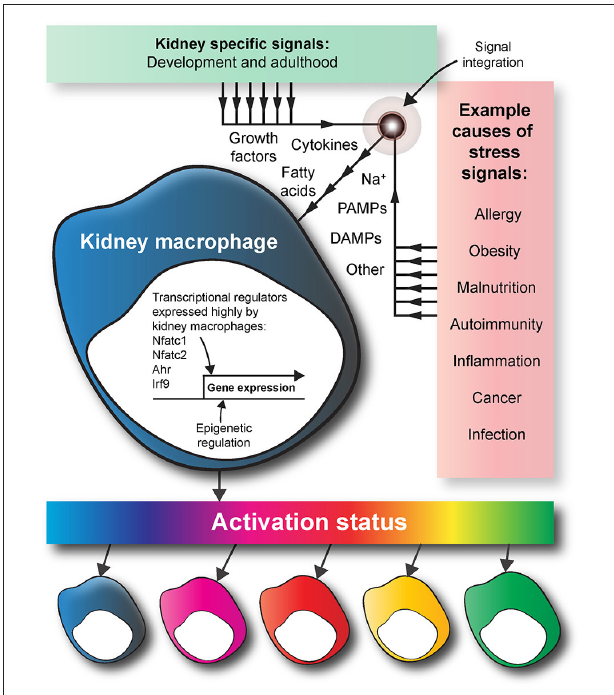
FIGURE 4 | Kidney macrophage specification. During development, the tissue-specific signals that kidney macrophages are exposed to provoke the expression of a unique array of transcriptional regulators. Compared to other tissue-resident macrophages, kidney macrophages have increased expression of transcriptional regulators such as Nfatc1, Nfatc2, Ahr, and Irf9. In adulthood, macrophages are exposed to various exogenous stress signals because of factors such as disease, diet, and infection. Based on the multidimensional model of macrophage activation, a macrophage is specified by the integrated effects of the endogenous and exogenous signals within its micro-anatomical site. The macrophage colors are used to show the heterogeneity of macrophage activation status in response to endogenous and exogenous signals in the kidney. DAMPS, damage-associated molecular